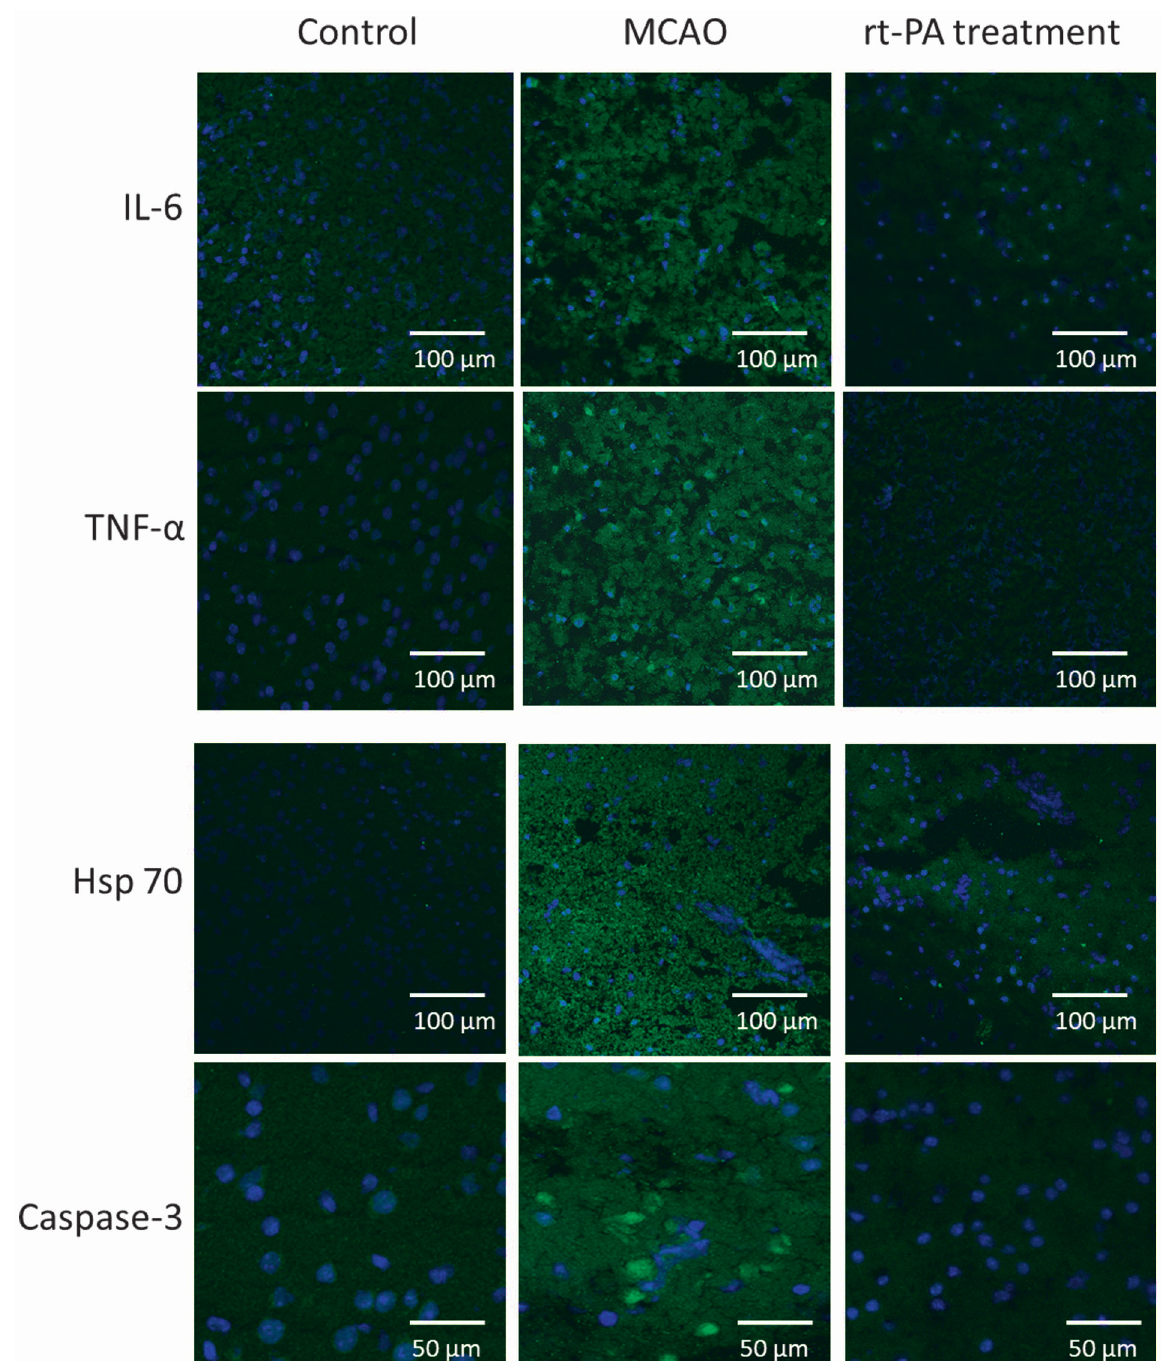
Figure 4. Effect of administration of rt-PA on protein expression. Sections from the infarction core showing IL-6, TNF- a , Caspase 3, MMP-9, and hsp 70 protein expressions. The images represent the control group (A, D, G, J, M and P), MCAO (B, E, H, K, N, Q) and MCAO + rt-PA treatment (C, F, I, L, O, R). There are significant increases in IL-6, TNF- a , Caspase 3 and hsp 70 protein levels in the MCAO group compared to the control group. Treatment with rt-PA prevented the increase in expression of these proteins in those animals that recanalized after treatment. There was a slight increase in hsp 32 and MMP-9 protein expression in ischemic brain tissue as compared to control. Data were obtained with confocal microscopy. spontaneous recanalization within 10 minutes. The mortality rate was 32% and the animals died either during the surgery or overnight. There was no difference in the mortality rate between the groups.